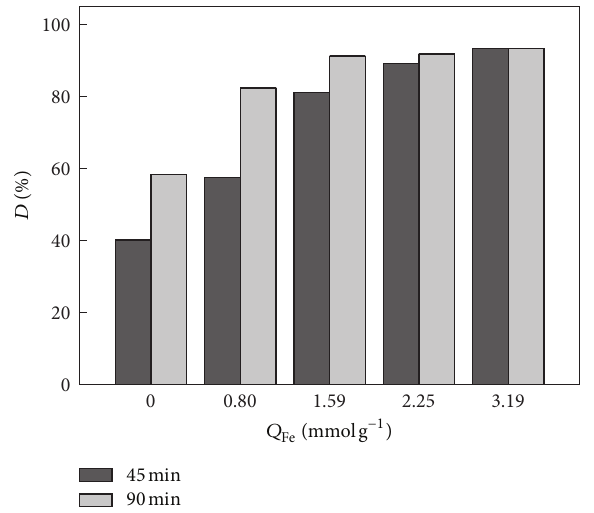
Figure 5: Degradation of RR 195 by Fe-AO-n-PAN with different 𝑄 values. Fe